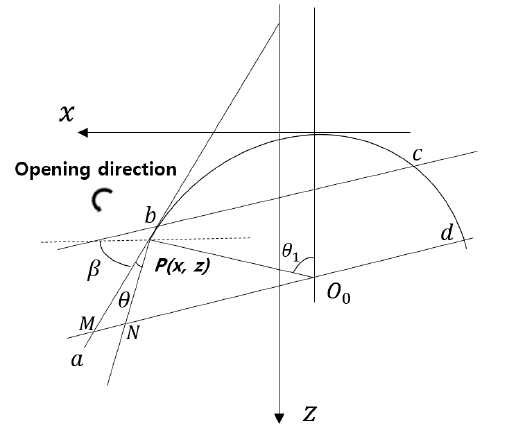
Figure 7. Contact angle of seal pair.